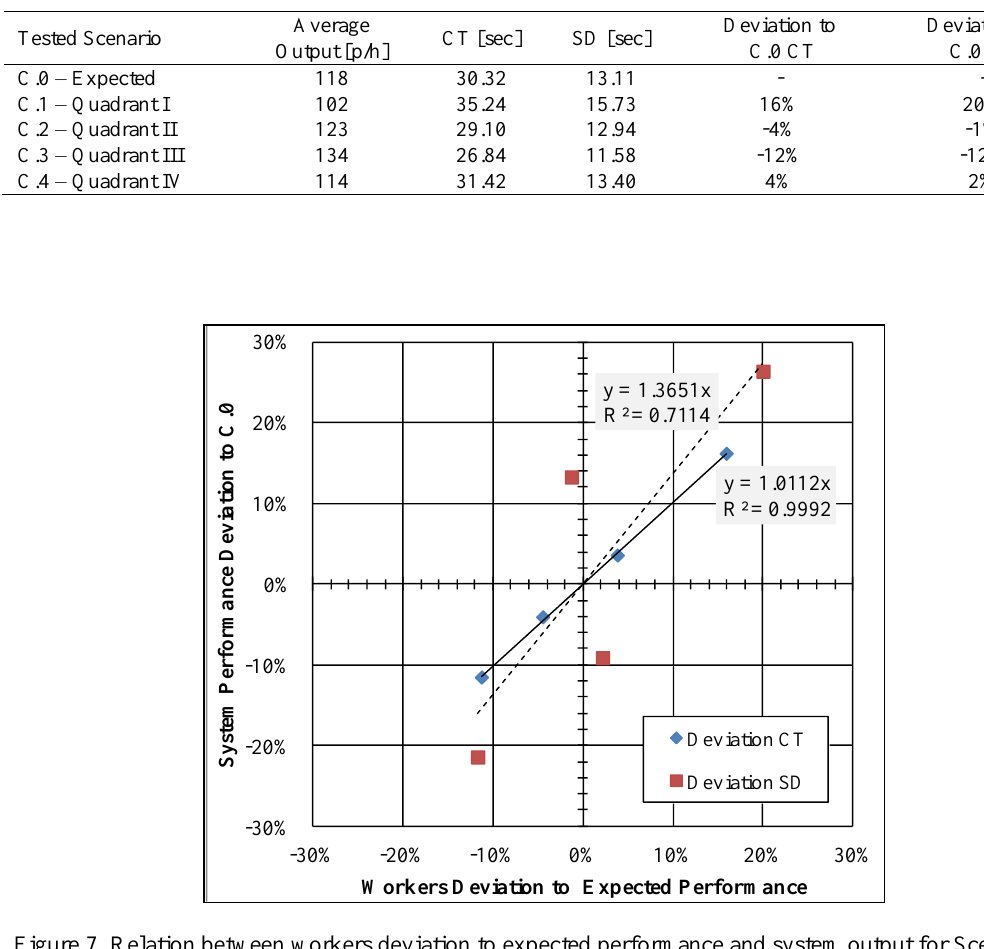
Figure 7. Relation between workers deviation to expected performance and system output for Scenarios C